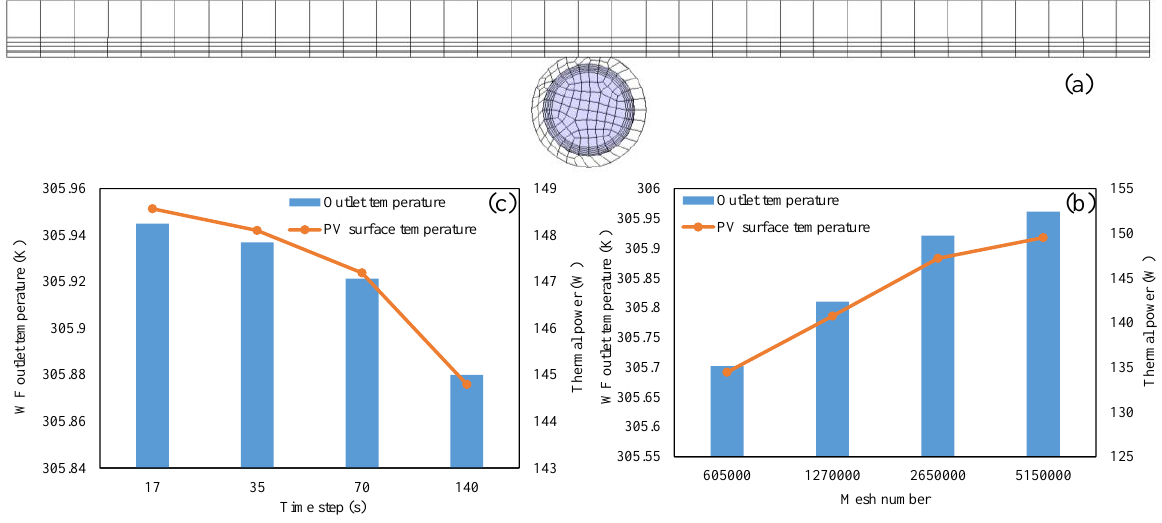
Fig. 3 (a) Sample of the structural grid system used for the PVT part of the system along with investigating the independence of (b) grid number and (c) time-step.